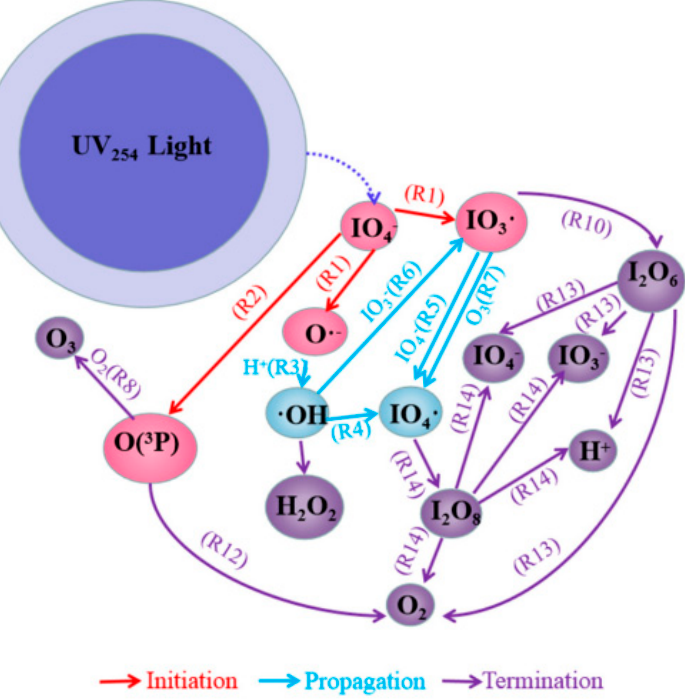
Figure 1. Schematic UV/IO 4 − process radical and reactive species production, transformation, and interconversion. Reprinted/adapted with permission from Ref. [29]. 2023, Elsevier.